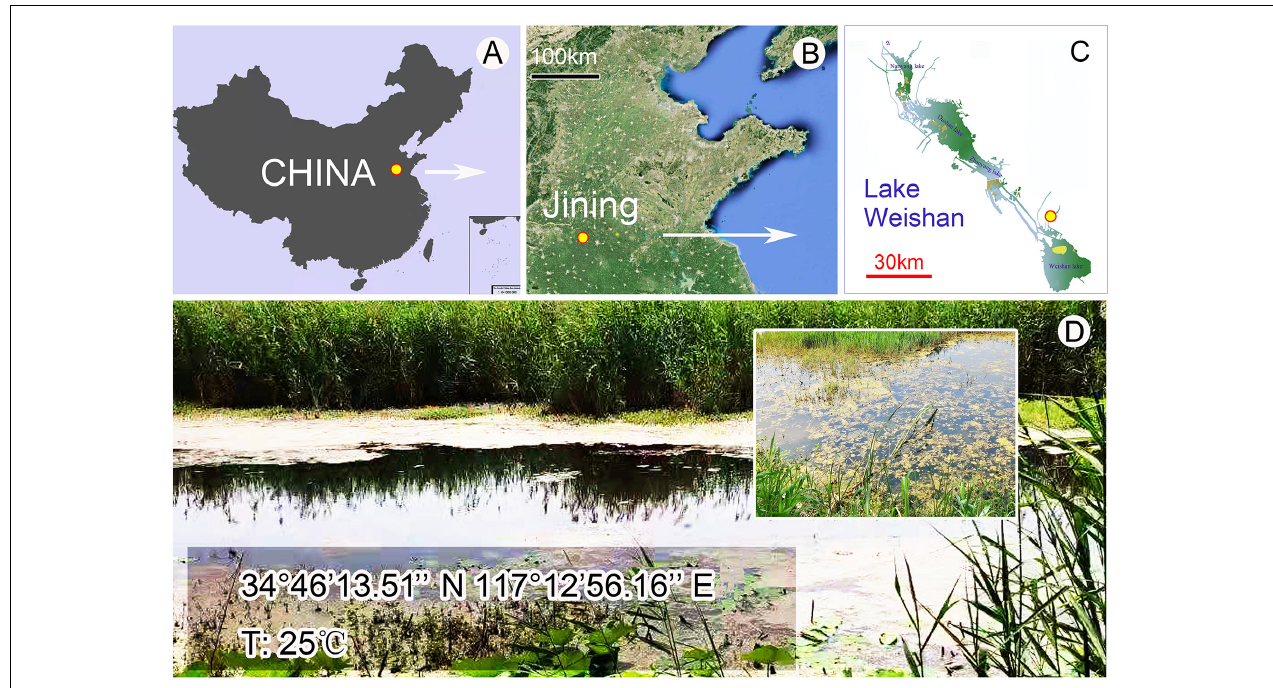
FIGURE 1 | Location of the sampling site. (A–C) Map showing the location of the Lake Weishan, China. (D) Photographs of the Lake Weishan where Metaurostylopsis alrasheidi n. sp. was collected.